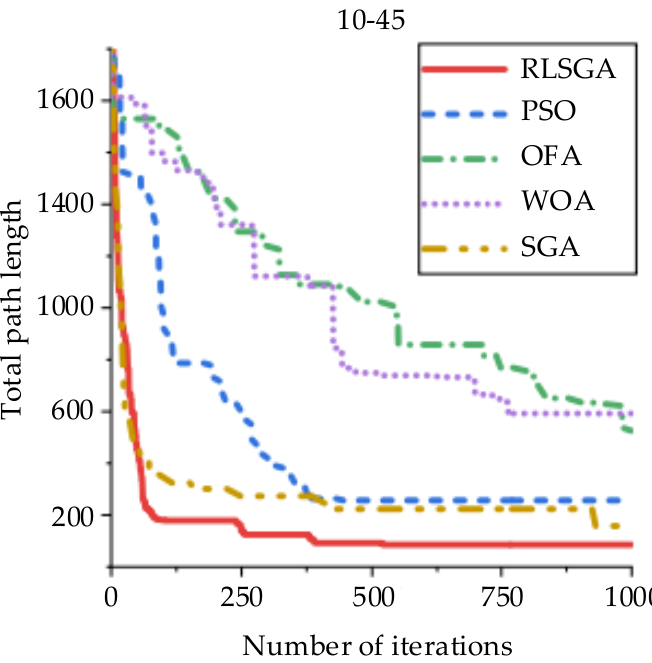
Figure 11. Comparison of rack travel distance between considering equilibrium and not consider- ing.